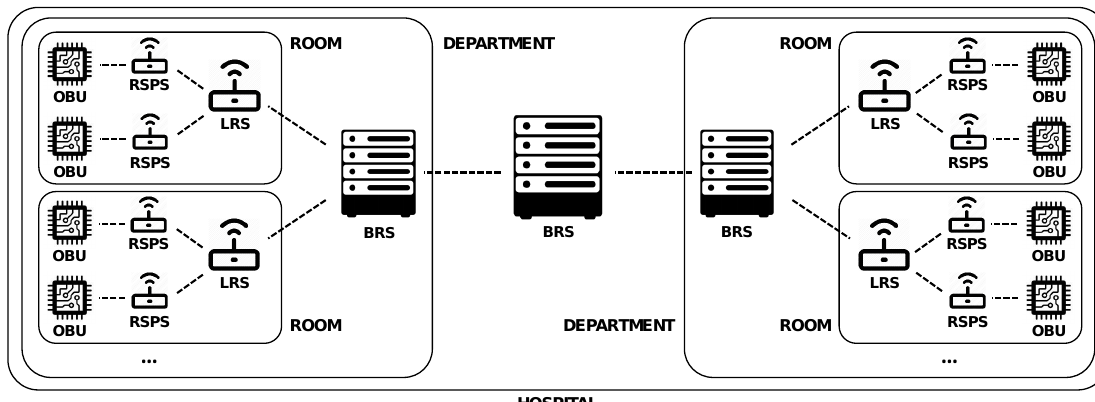
Figure 2. Potential deployment of the architecture of the cascading reasoning platform in a hospital setting. A network of components can be constructed. In this example, there is one Observation Unit (OBU) and RSP Service (RSPS) per patient, one Local Reasoning Service (LRS) per room, one Back-end Reasoning Service (BRS) per department, and another BRS for the full hospital. Potential external components are omitted from this